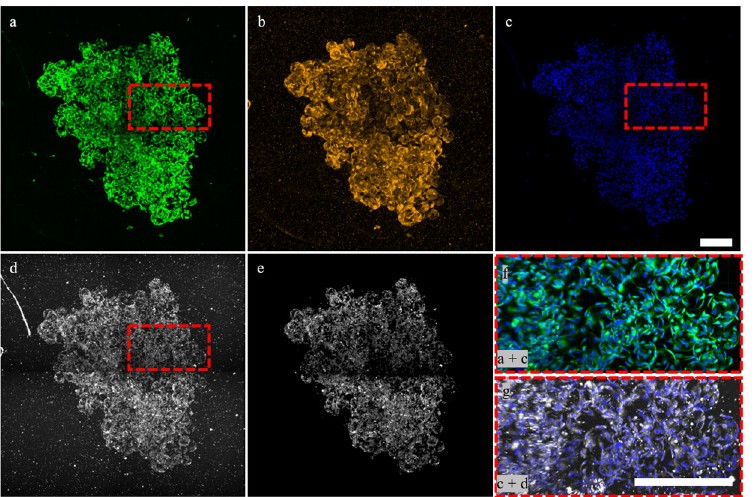
Fig 3. Large aggregates can be imaged and analyzed in toto using fluorescence and label-free LSM. 2D maximum fluorescence intensity Z-projections of ih-MSCs labeled with a) CTG, b) DiI, and c) DRAQ-5. (d) Elastic scattering also allows for visualization of cells within large aggregates. e) Small scatterers in agarose and cell debris can be segmented out based on intensity and/or size using Imaris. f) CTG + DRAQ-5 merge and g) elastic scattering + DRAQ-5 merge at higher resolution. Scale bar = 400 μ